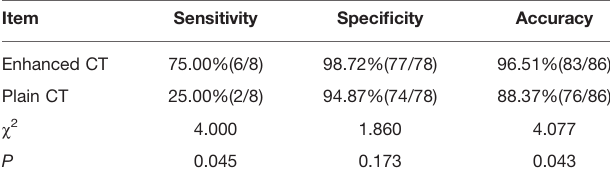
TABLE 6 | Comparison of the results of contrast-enhanced and non-enhanced CT in the diagnosis of nerve invasion in lung adenocarcinoma [ n (%)].